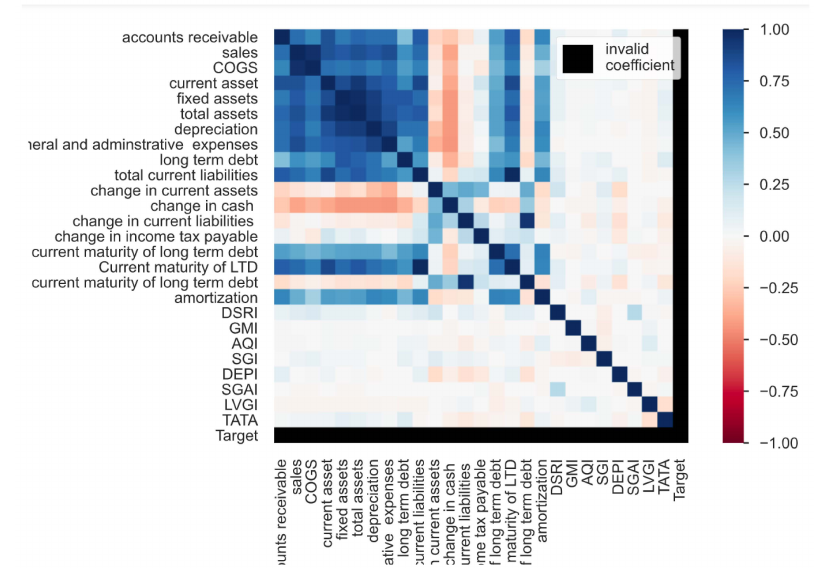
Figure 2. Pearson’s r correlation.